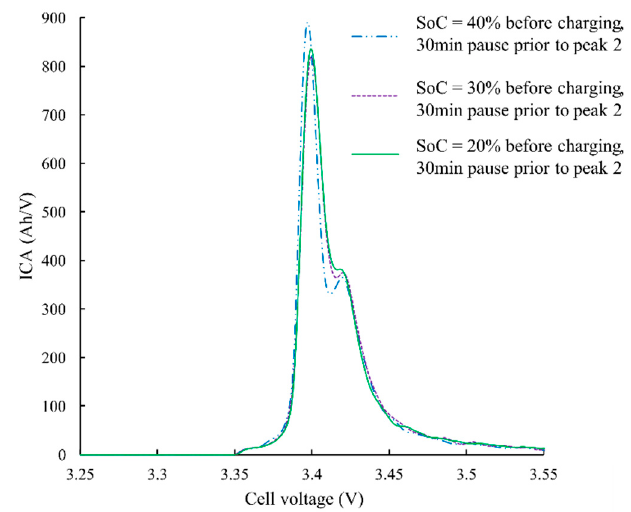
Figure 7. IC curves for different DoD and a pause of 30 minutes prior ICA peak 2.